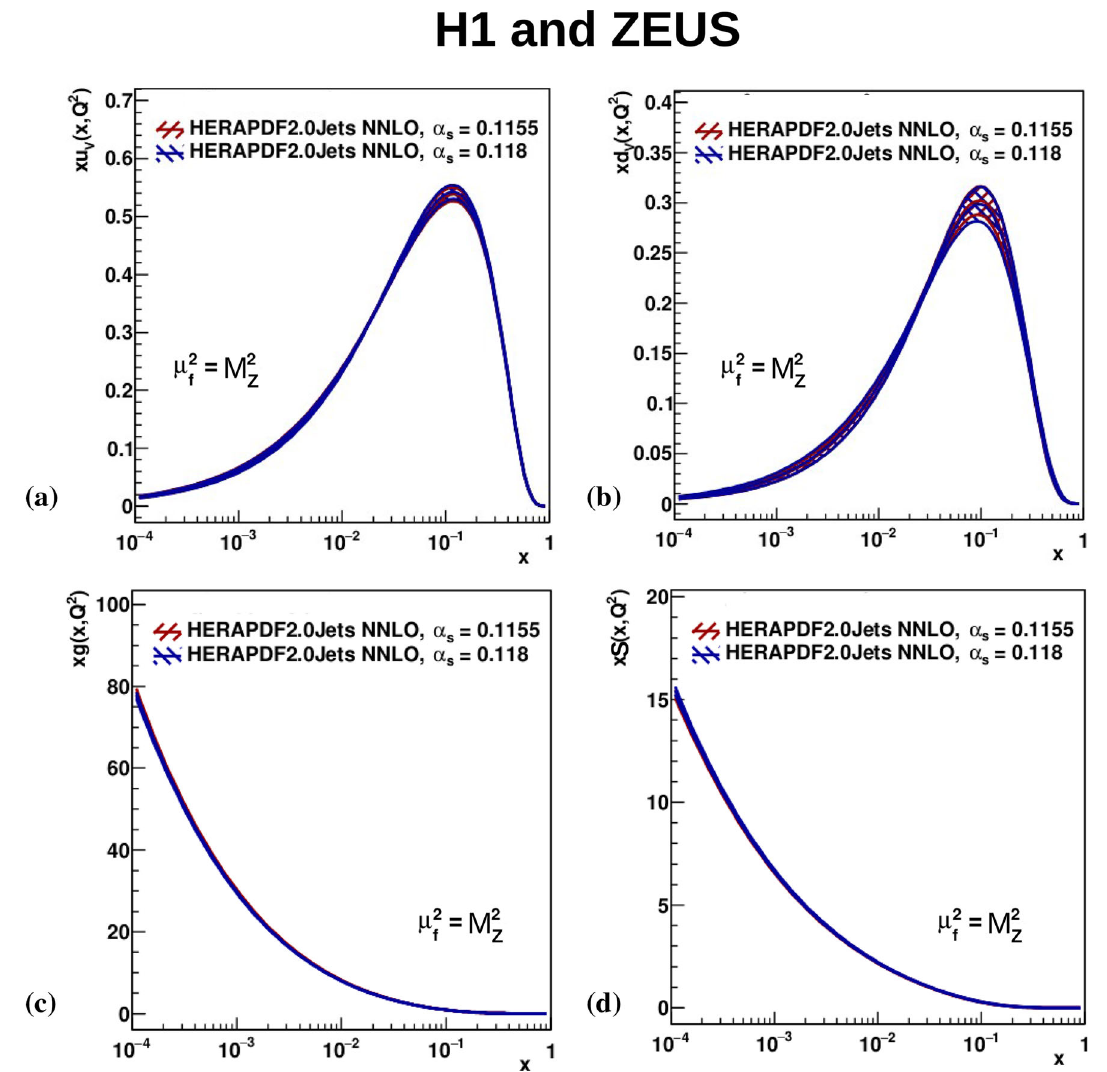
= M 2 with M Z = 91 . 19GeV at the scale μ 2 Z f ( M 2 ) = 0 . 118, s Z